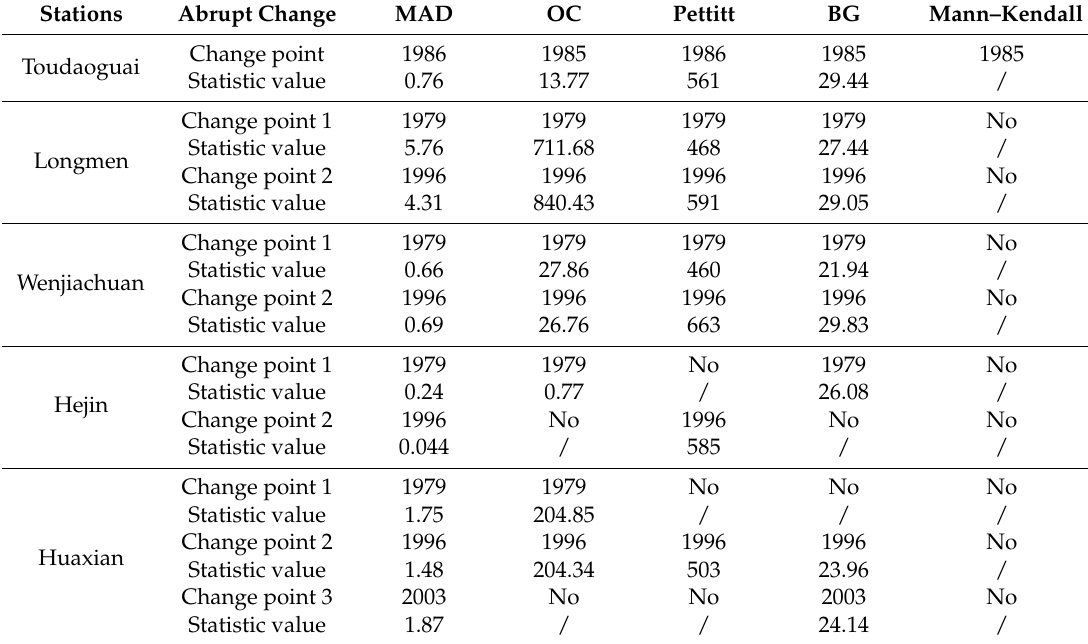
Four conclusions can be drawn from Table 5 and Figure